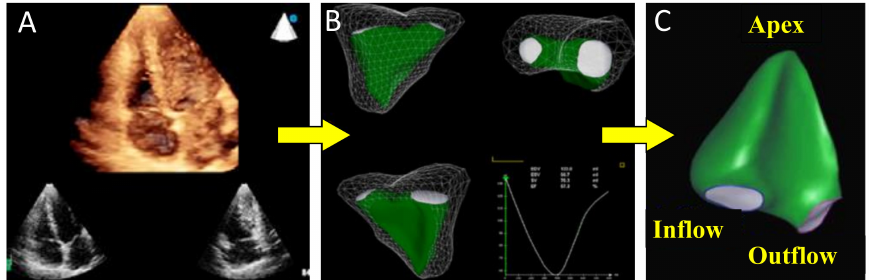
Figure 5. Acquisition and reconstruction of the right ventricle (RV). ( A ): adapted 4-chamber view for acquisition of the entire RV cavity; ( B ): reconstruction on the display of the RV cast (cine loops) and all measurements (RV volumes and function). ( C ): magnification of the RV cast and morphology of inflow, outflow and apex of the